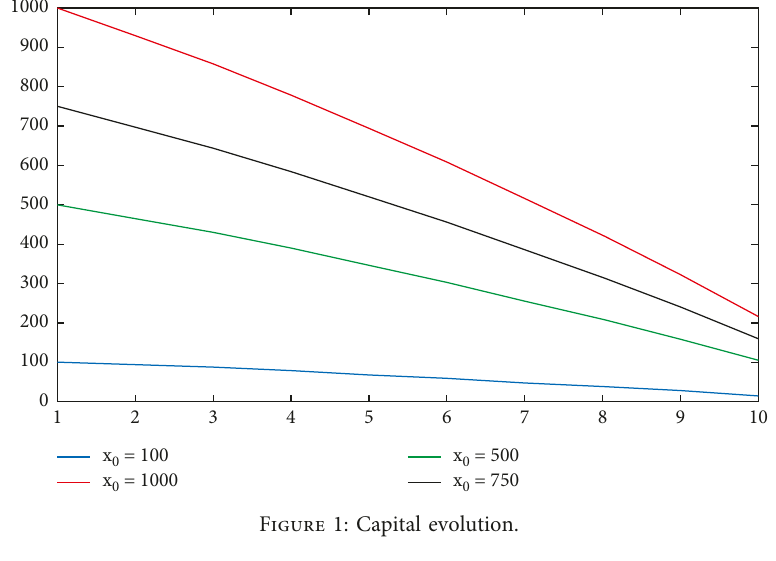
Figure 1: Capital evolution.